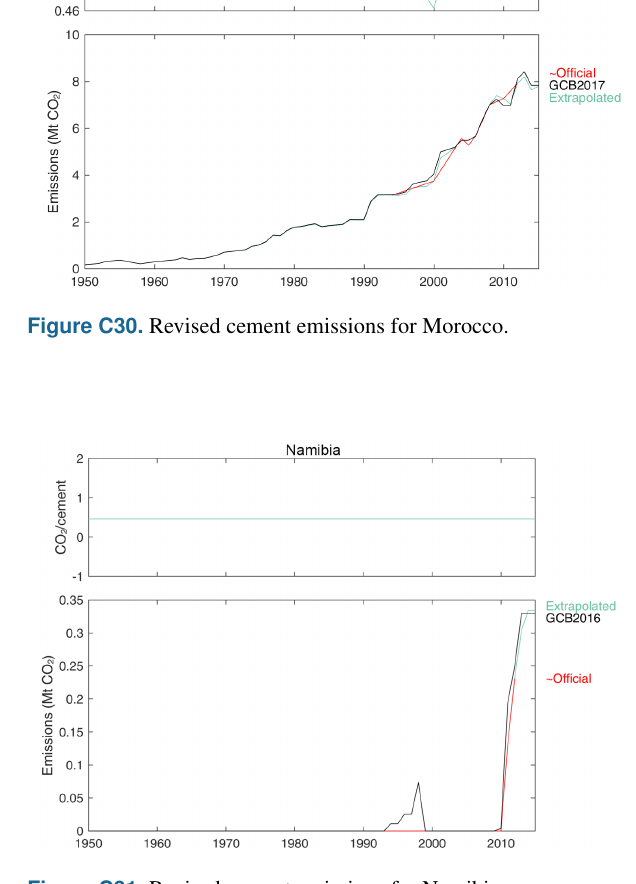
Figure C31. Revised cement emissions for Namibia.